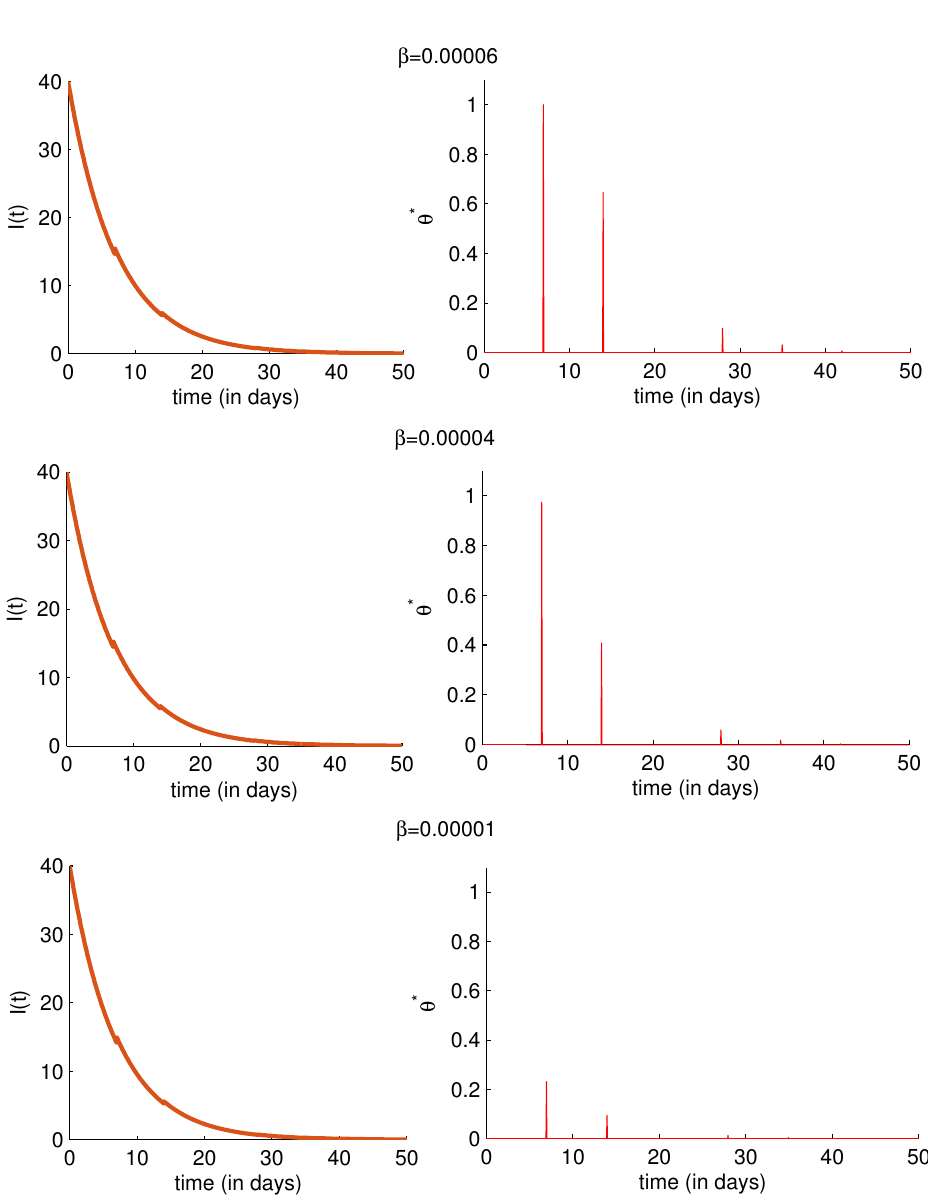
Figure 6. Infection and impulse optimal controls for different values of β . The other parameters are the same as in Figure